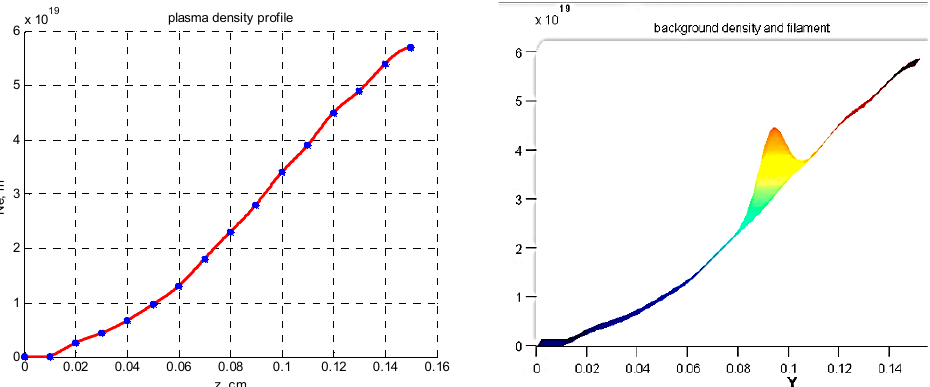
Figure 1. ( left ) Experimental electron density profile for Globus-M2, ( right ) experimental electron density profile for Globus-M2 with introduced filament distribution.